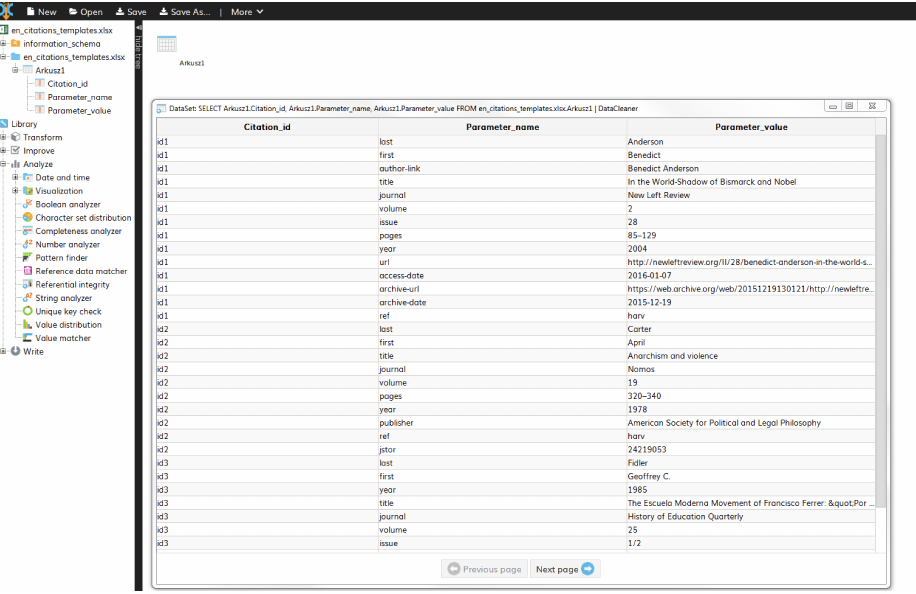
Figure 4. Example of the analyzed reference data in